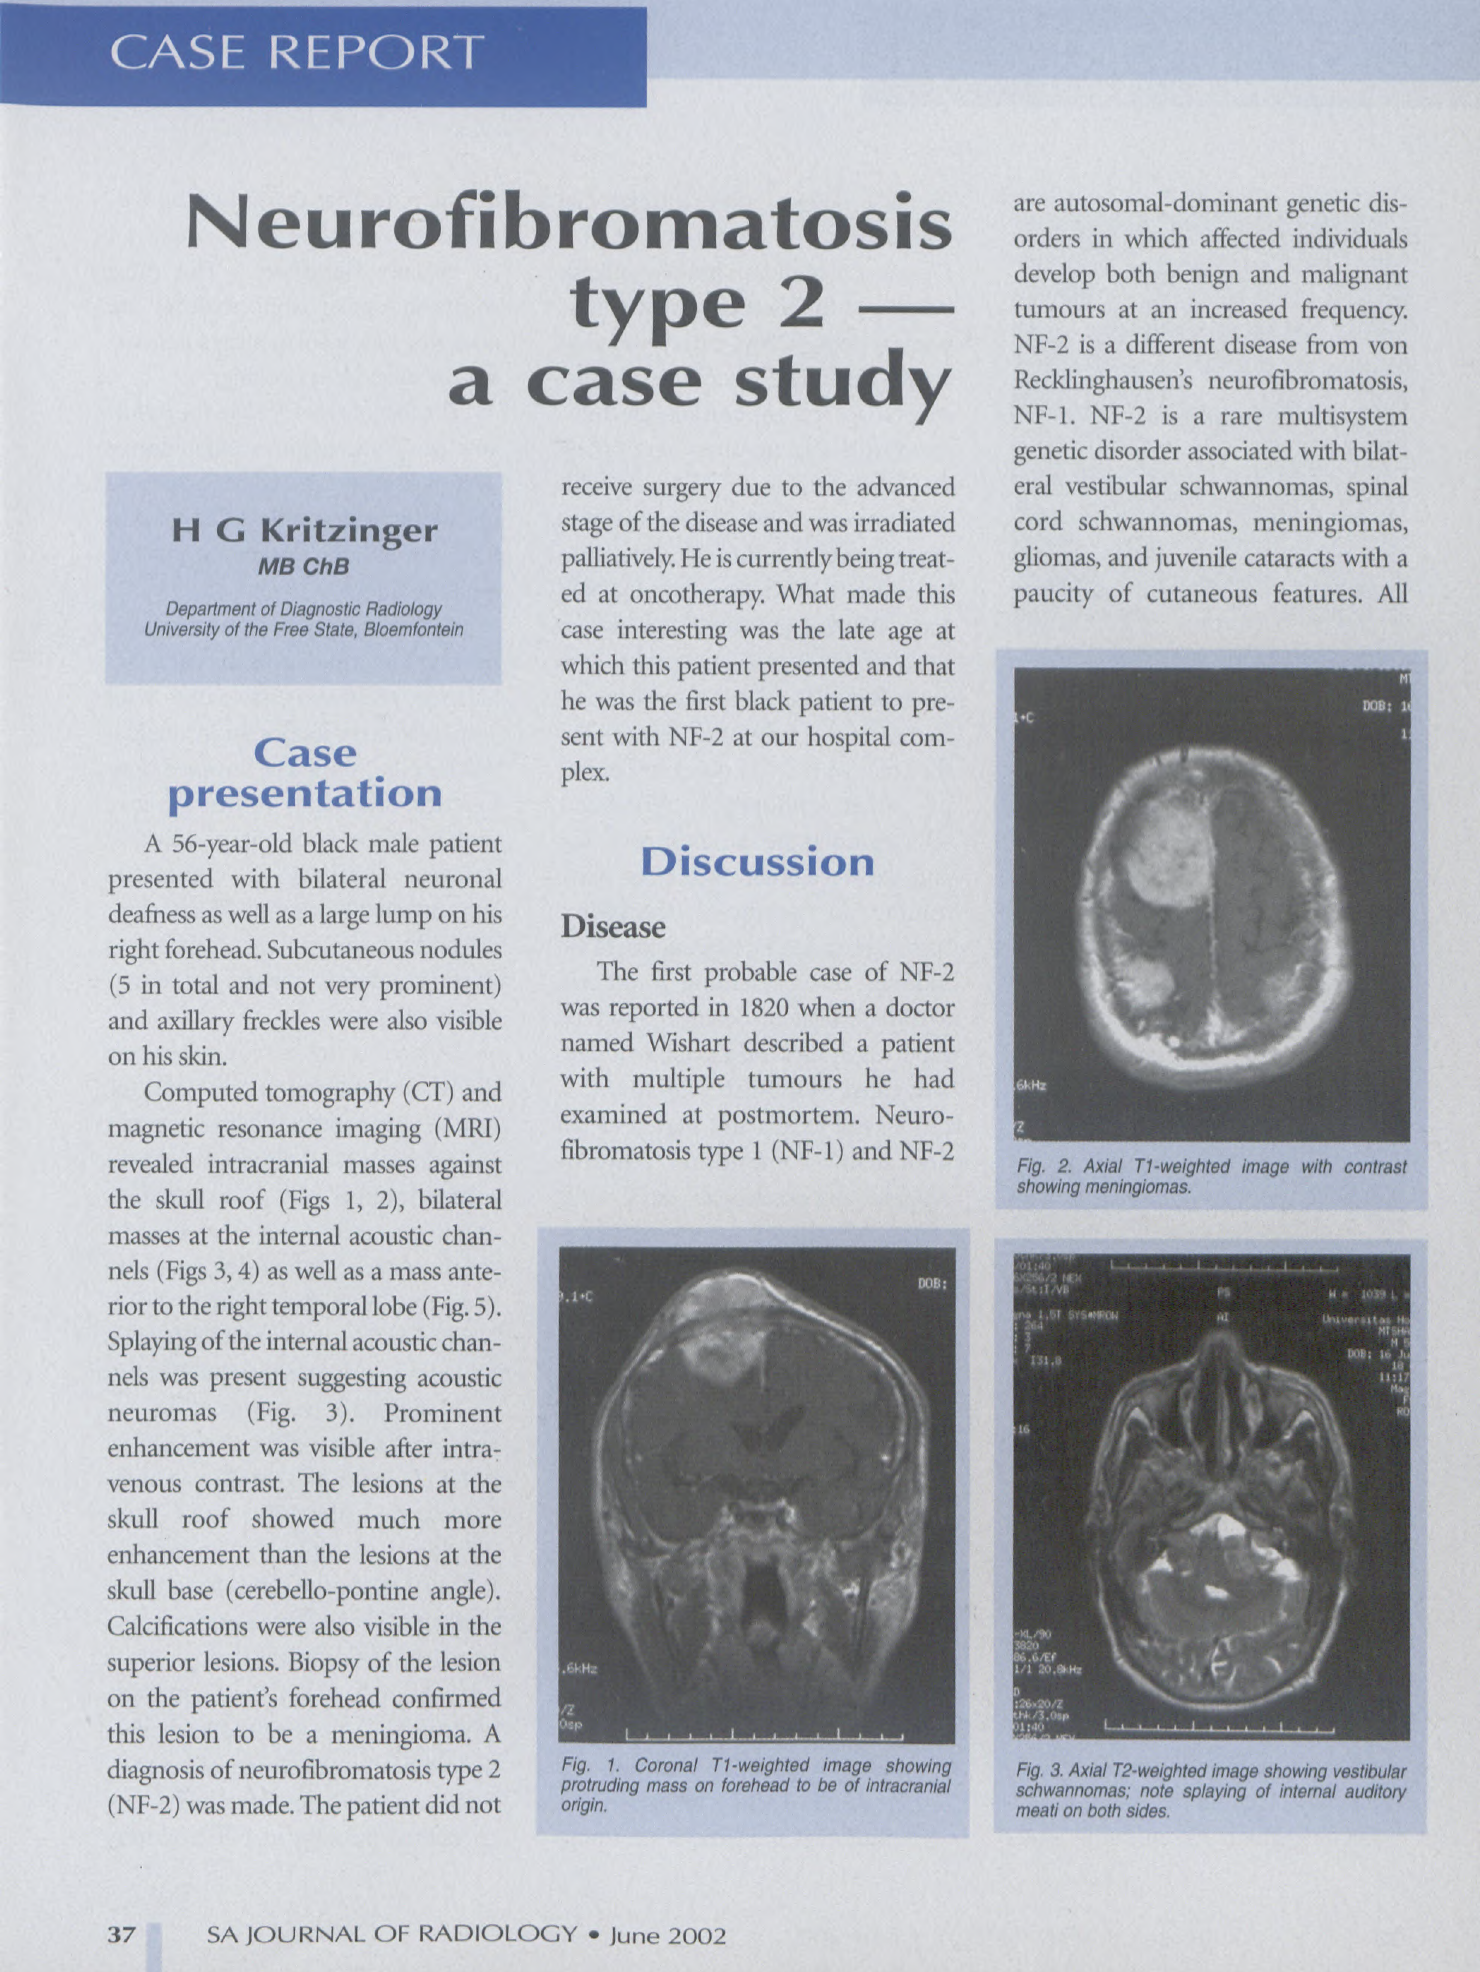
Fig. 1. Coronal n·weighted image showing protruding mass on forehead to be of intracranial origin.